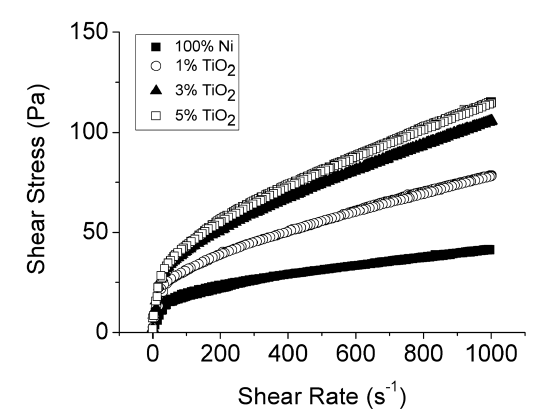
Figure 2: Flow curves of 30 vol.% suspensions of Ni-TiO with different TiO